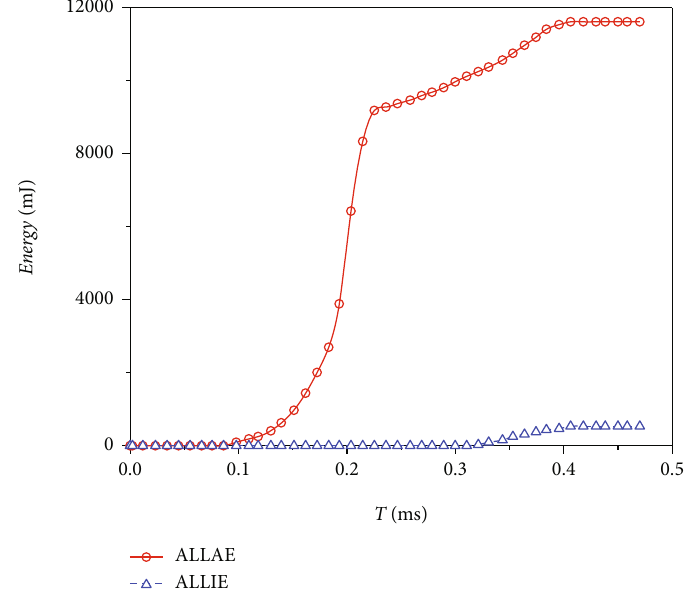
Figure 13: Time history curves of the hourglass energy and internal